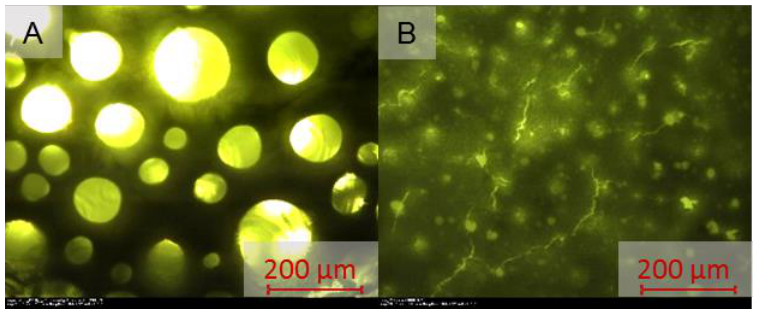
Figure 8. Dried polysorbate 80 foam with ( A ) 20% and ( B ) 40% maltodextrin contents.